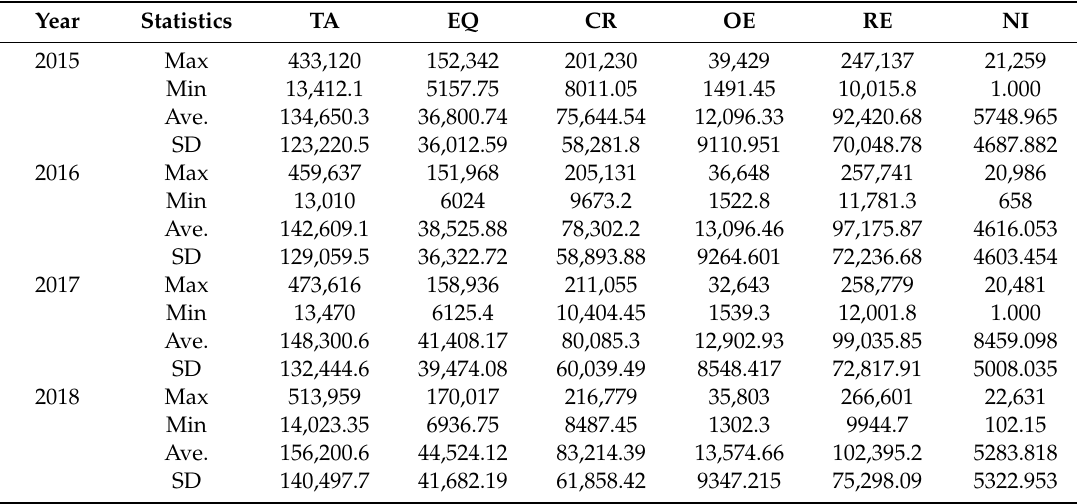
Table 2. Summary of statistics for each year